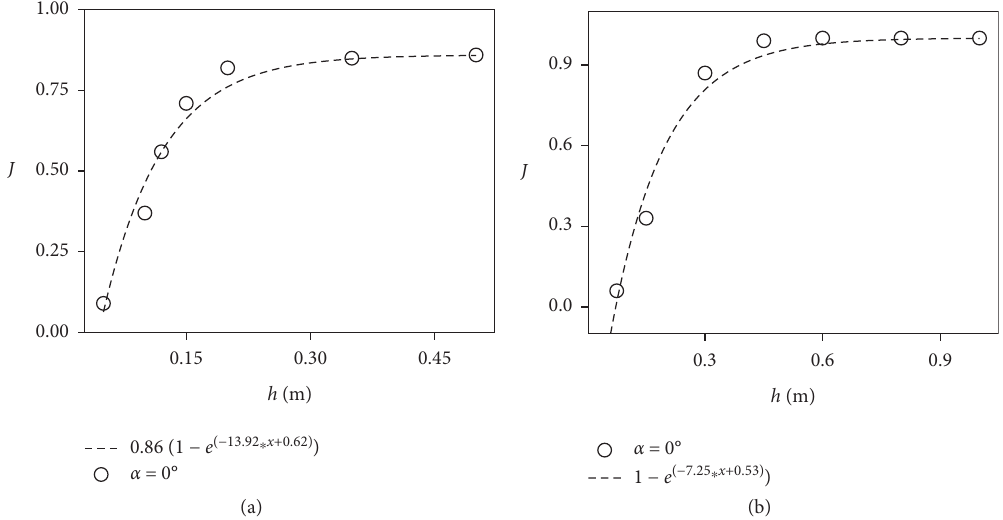
Figure 9: Results of clogging probability J versus pebble bed height h for flat-bottom hopper ( α � 0 ° ) obtained by (a) experiment and (b) simulation. The dashed lines represent equation (5) with J � 0 . 53 in C 2